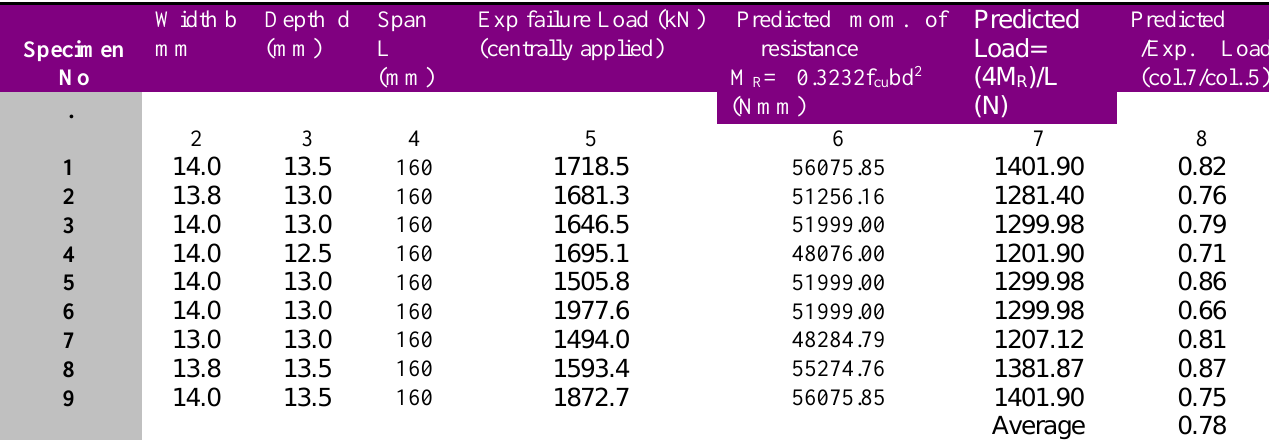
Comparison between experimental and designed (predicted) ultimate load on air-dried Ekki beam loaded in flexure using compression eqn. (33) f